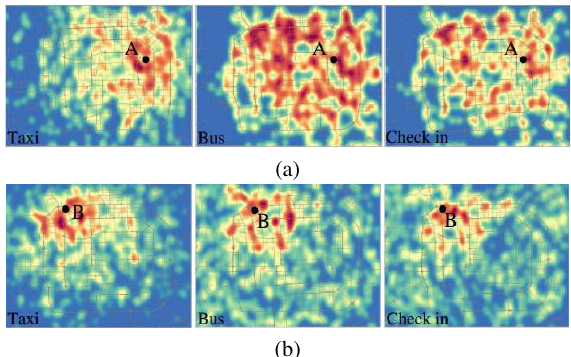
Fig. 13 Spatial influence of a location using a gravity model based on taxi, bus, and check-in datasets. (a) Point A is a bus district, (b) point B is an IT district [47]